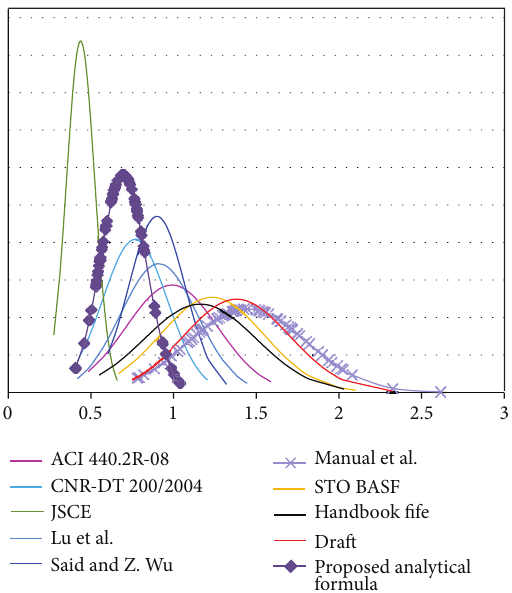
Figure 5: Normal distributions for proposed analytical formula 𝑥 2